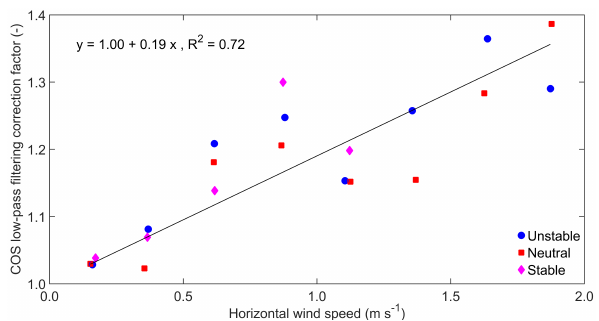
Figure 4. Wind speed dependence of experimentally derived low-pass filtering correction factors for COS. Symbols refer to different stability conditions (unstable: z/L < − 0.25; neutral: − 0.25 ≤ z/L ≤ 0.25; stable: z/L >0.25), the solid black line to a linear regression (coefficients and coefficient of determination are indicated in the upper-left